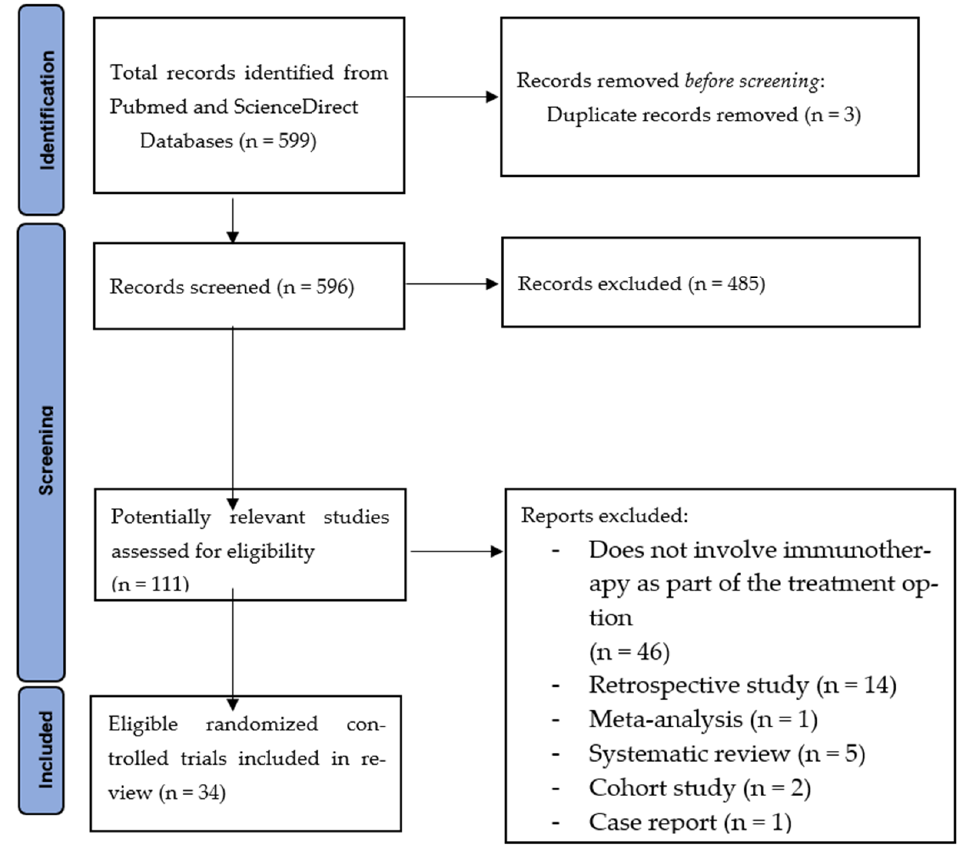
Figure 1. PRISMA flow chart.